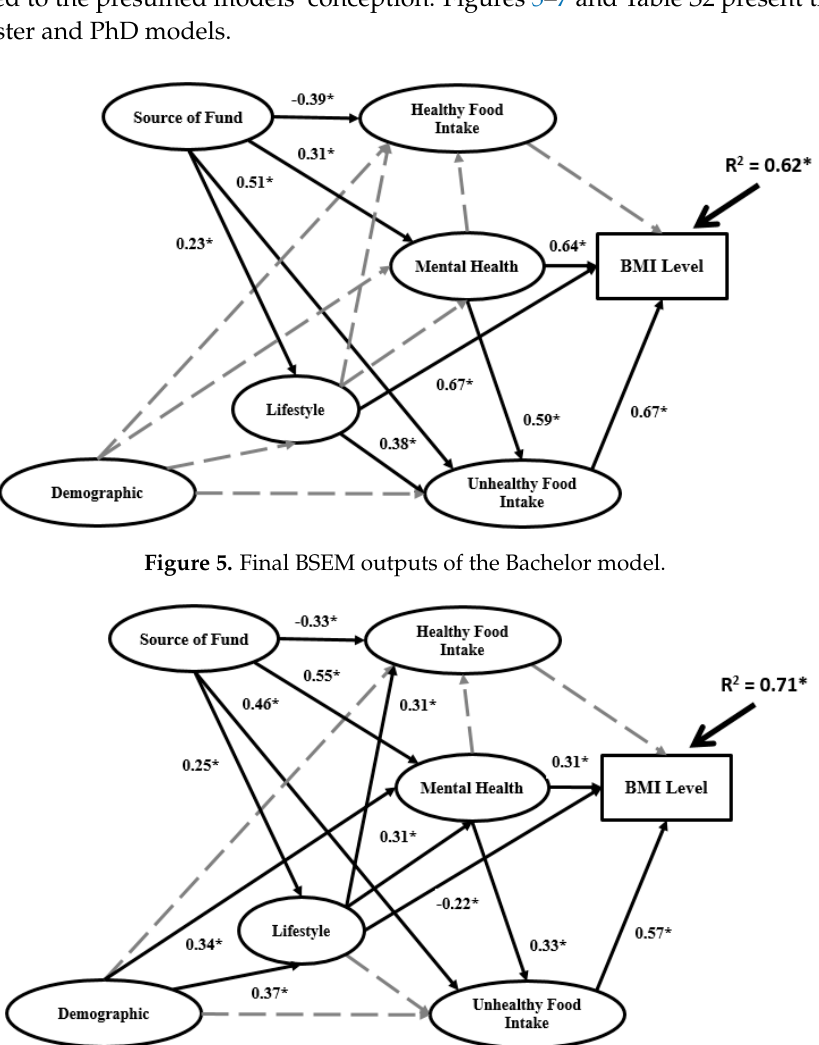
Figure 7. Final BSEM outputs of the PhD model.